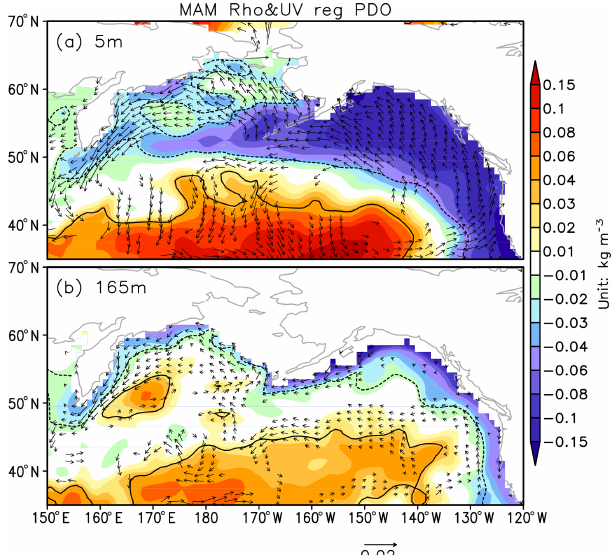
Figure 11. (a) Regressions of surface (5m) density (color shading) and zonal and meridional velocities (vector) onto the PDO index. Solid (dashed) lines enclose the positive (negative) density anoma- lies that are significant at the 95% confidence level. Only the ve- locity anomalies that are significant at the 95% confidence level are plotted. (b) Same as (a) , but for the subsurface layer (165m).